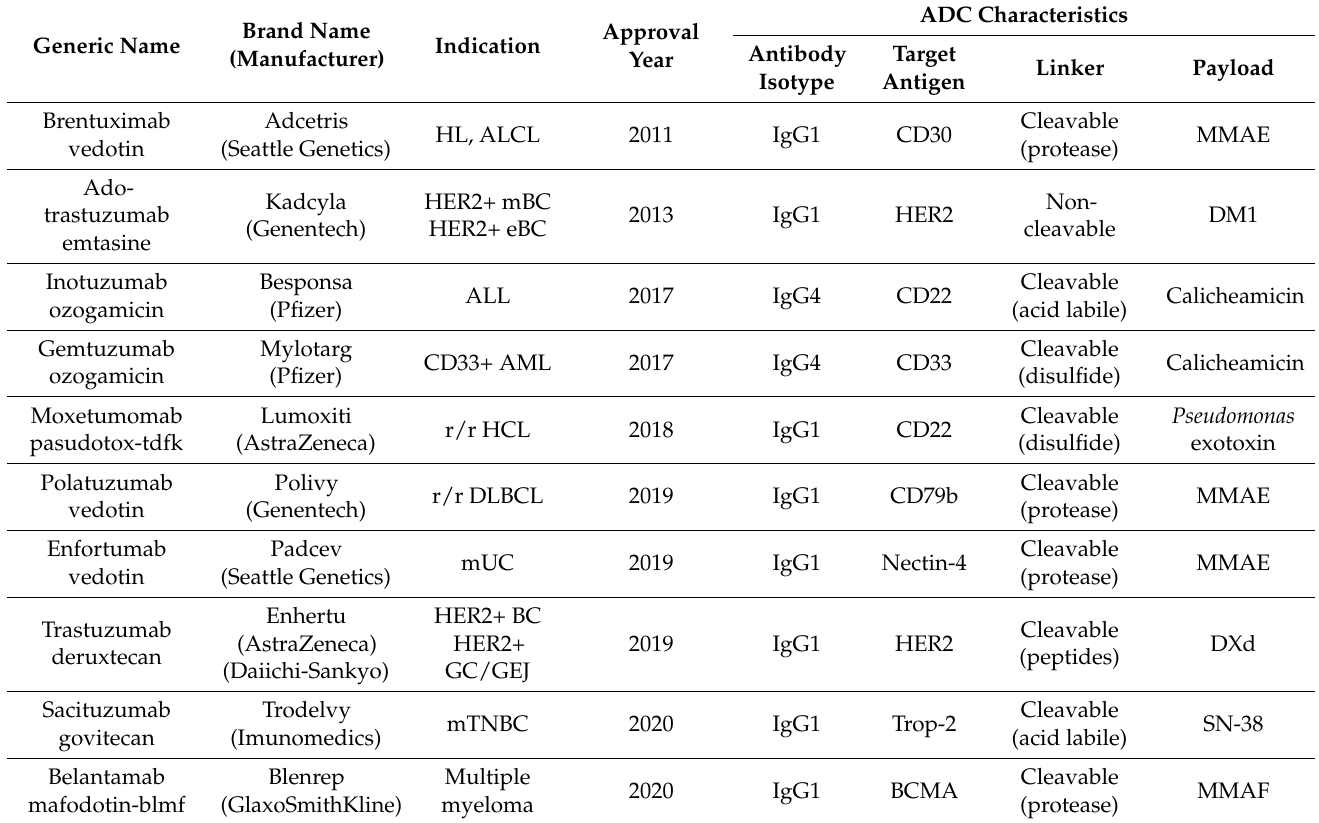
Table 1. Antibody-drug conjugates approved by the